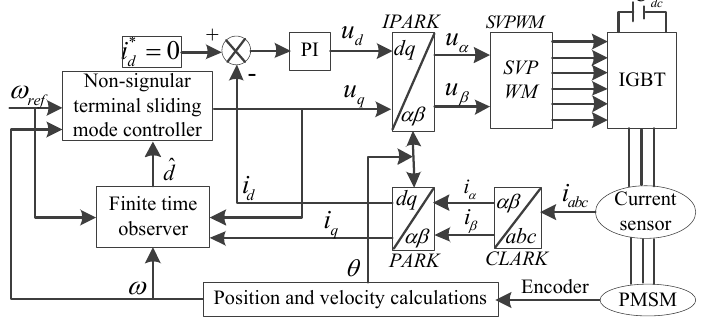
Figure 1. Permanent magnet synchronous motor (PMSM) control system based on the method designed in this paper.